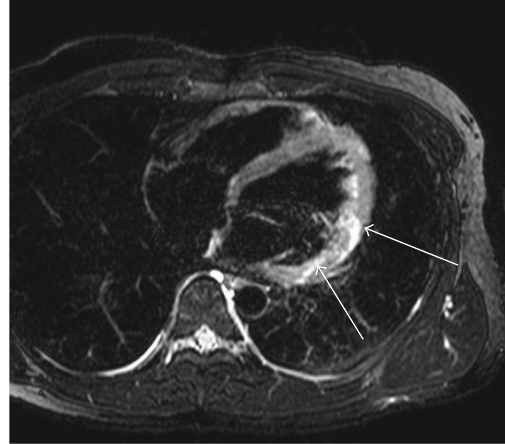
Figure 4: 50-year-old female with Churg-Strauss syndrome. Short- axis T2-weighted MRI shows patchy myocardial edema of the papillary muscle (arrow) in the eosinophilic myocarditis associated with this